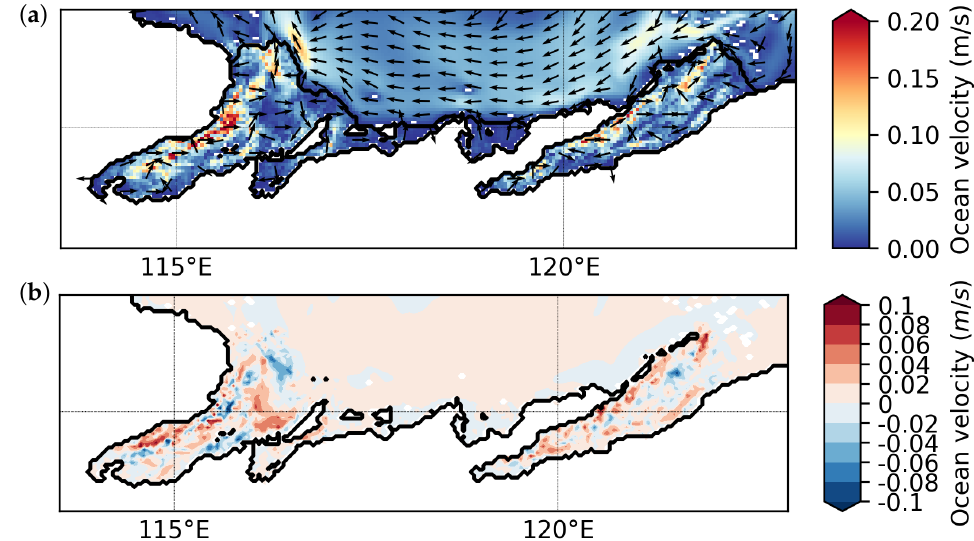
Figure 6. Mean ocean current velocity at the ice–ocean interface in REF ( a ). Differences in ocean current speed at the ice–ocean interface between REF3mcpl and REF ( b ), averaged over 1995–2014. Vertical sections of ocean temperature, salinity and meridional velocity across the TIS cavity are shown in Figures A3 and A4 (in Appendix A). The bottom of the cavity is filled with colder ( − 0.1 ◦ C) and fresher waters ( − 0.01 g kg − 1 ) in REF3mcpl, which is the opposite of what is found at the ice–ocean interface (warmer and saltier in REF3mcpl). The ocean stratification seems to be similar in both REF3mcpl and REF. The temperature and salinity higher salinity in REF3mcpl) and may explain the lack of changes in stratification inside